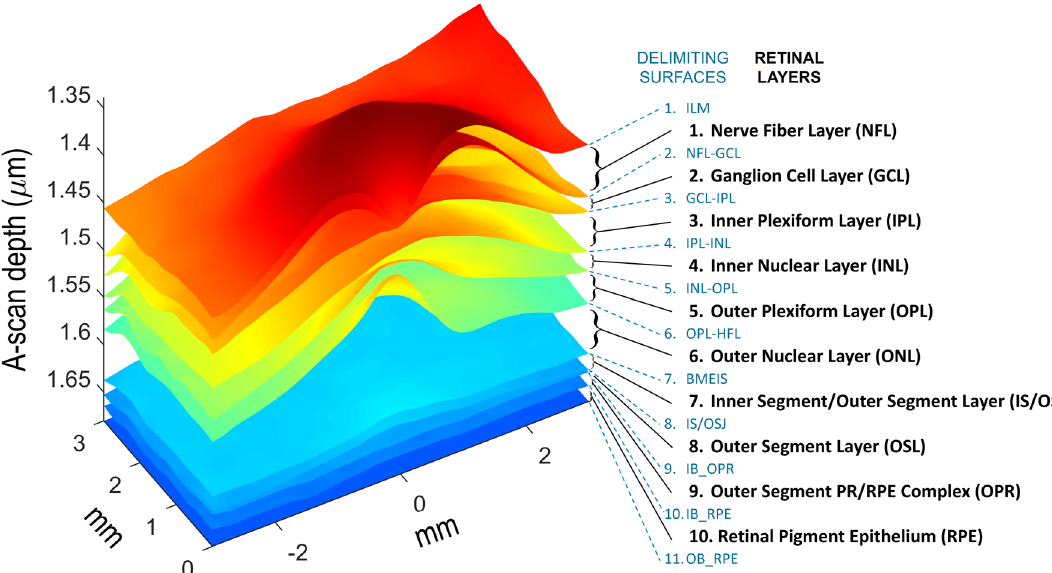
Figure 6. Retinal layers and their delimiting surfaces. Retinal layers: (1) nerve fiber layer (NFL), (2) ganglion cell layer (GCL), (3) inner plexiform layer (IPL), (4) inner nuclear layer (INL), (5) outer plexiform layer (OPL), (6) outer nuclear layer (ONL), (7) inner segment/outer segment layer (IS/OS), (8) outer segment layer (OSL), (9) outer segment PR/RPE complex (OPR), (10) retinal pigment epithelium layer (RPE). Delimiting surfaces: (1) inner limiting membrane (ILM), (2) nerve fiber layer-ganglion cell layer (NFL-GCL), (3) ganglion cell layer- inner plexiform layer (GCL-IPL), (4) inner plexiform layer-inner nuclear layer (IPL-INL), (5) inner nuclear layer-outer plexiform layer (INL-OPL), (6) outer plexiform layer-Henle fiber layer (OPL-HFL), (7) boundary of myoid and ellipsoid of inner segments (BMEIS), (8) inner segment-outer segment junction (IS/OSJ), (9) inner boundary of OPR (IB_OPR; OPR: outer segment PR/RPE complex), (10) inner boundary of retinal pigment epithelium (IB_RPE), and (11) outer boundary of retinal pigment epithelium (OB_RPE). Image created